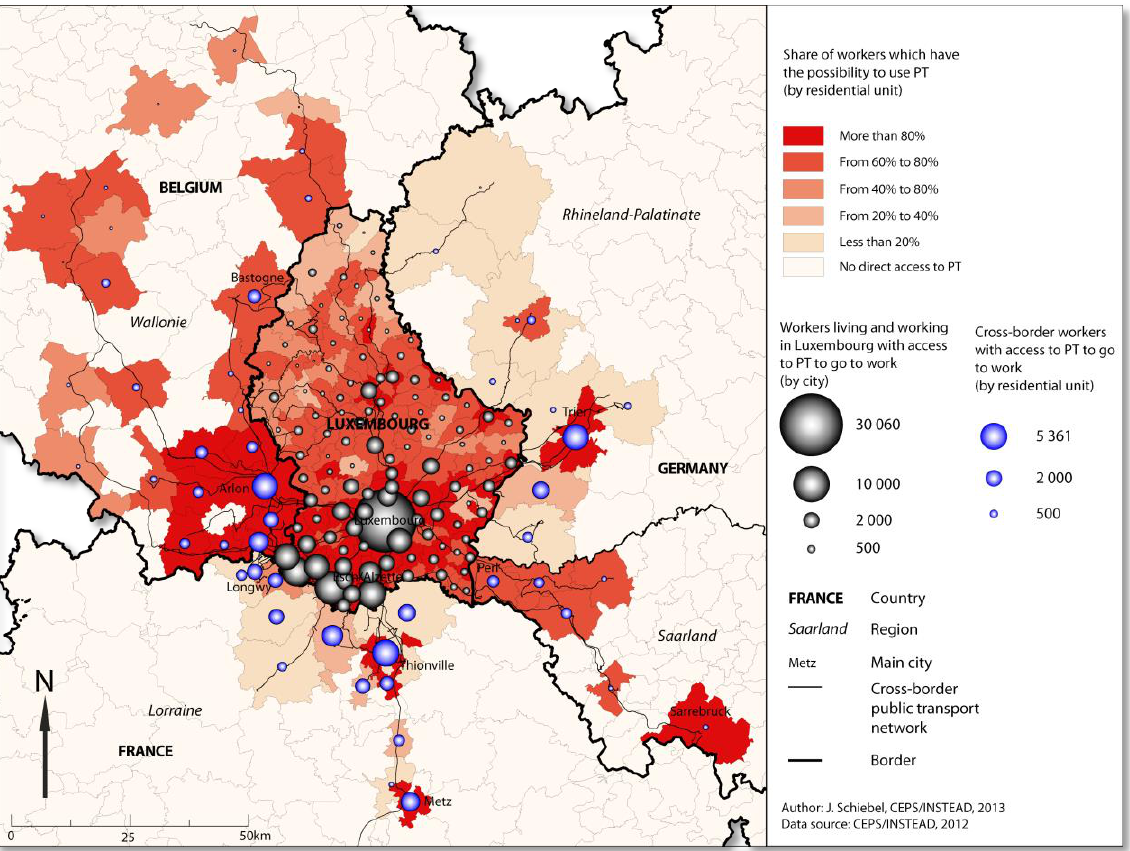
Figure 1. Direct access to the workplace by public transport: comparison between Luxembourg and its bordering